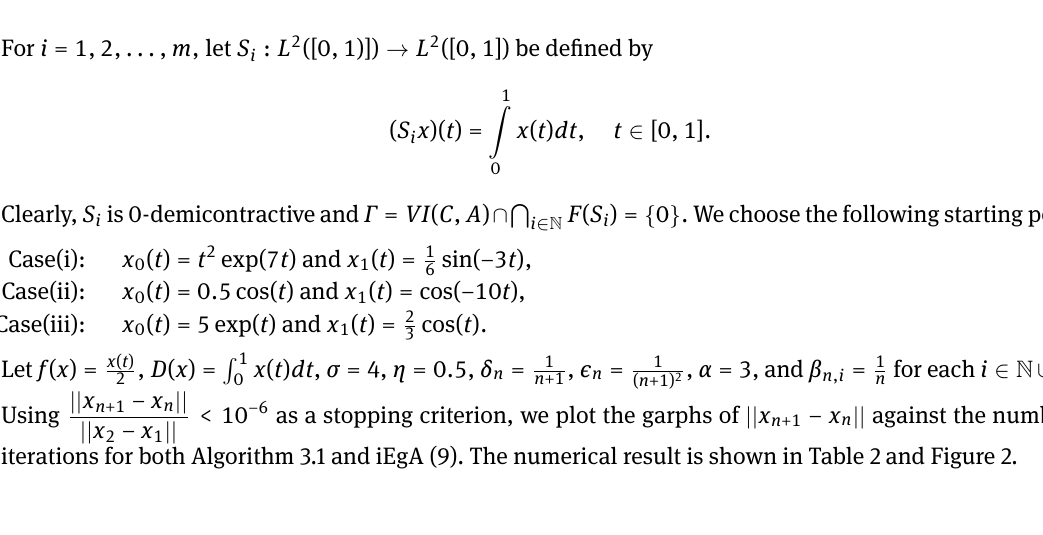
Algorithm 3.1 THSEgM(I)